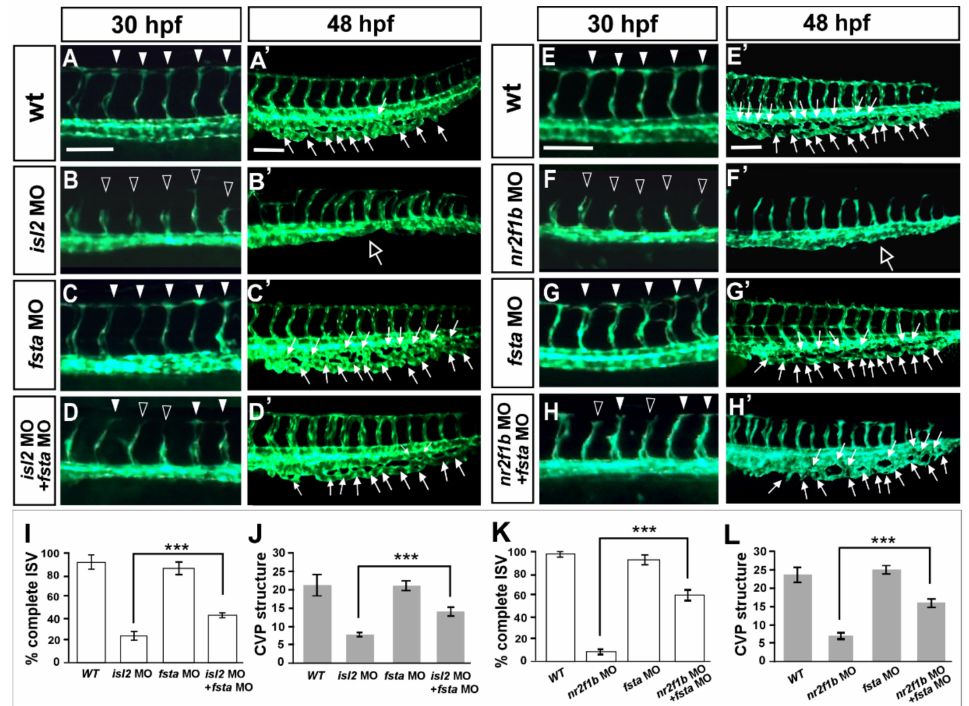
Figure 6. Knockdown of fsta rescues the vascular defects in isl2 and nr2f1b morphants. When compared to vascular patterns in wild type embryos ( A , A (cid:48) , E , E (cid:48) ,), the loss of fsta by morpholino injection does not cause obvious vascular defects ( C , C’ , G , G’ ), and the knockdown of isl2 or nr2f1b showed ISV growth defects at 30 hpf ( B , F ) and CVP mis-patterning (hollow arrows in ( B (cid:48) , F (cid:48) )). Double knockdown of fsta and isl2 ( fsta MO + isl2 MO) or fsta and nr2f1b ( fsta MO + nr2f1b MO) showed less ISV stalling ( D , H ) when compared to isl2 MO or nr2f1b MO. ( I – L ) Quantitative results showed the significant rescue effect of isl2 MO or nr2f1b MO by fsta morpholino injection. Quantitated results for isl2 MO rescue experiments in wt ( n = 10), fsta MO ( n = 18), isl2 MO ( n = 13), and fsta MO + isl2 MO ( n = 15). For the quantification of nr2f1b MO rescue experiment: wt ( n = 10), fsta MO ( n = 18), nr2f1b MO ( n = 15), fsta MO + nr2f1b MO ( n = 13). These data are consistent with our microarray results; isl2 and nr2f1b negatively regulate fsta expression to control ISV/vein development. Data are represented as means ± S.E. *** refers to p < 0.0001 by an unpaired Student’s t -test. Scale bars represent 100 µ m